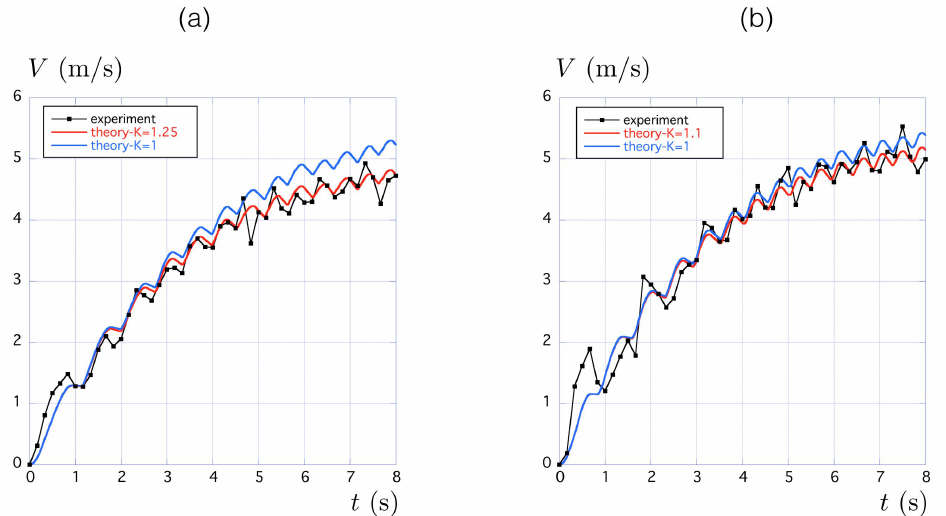
Figure 12. Comparison between the velocity measured experimentally and the one obtained by the numerical integration of Equation (6), for Athlete A1 ( a ) and for Athlete A2 ( b